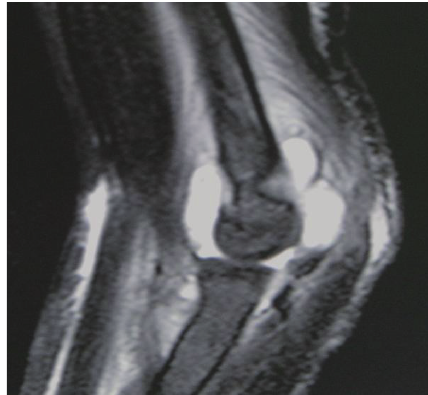
Figure 2: A fat suppressed T2-weighted MRI. A sagittal MRI revealed a presence of joint fluid pooling in the elbow and swelling of soft tissues around the joint.